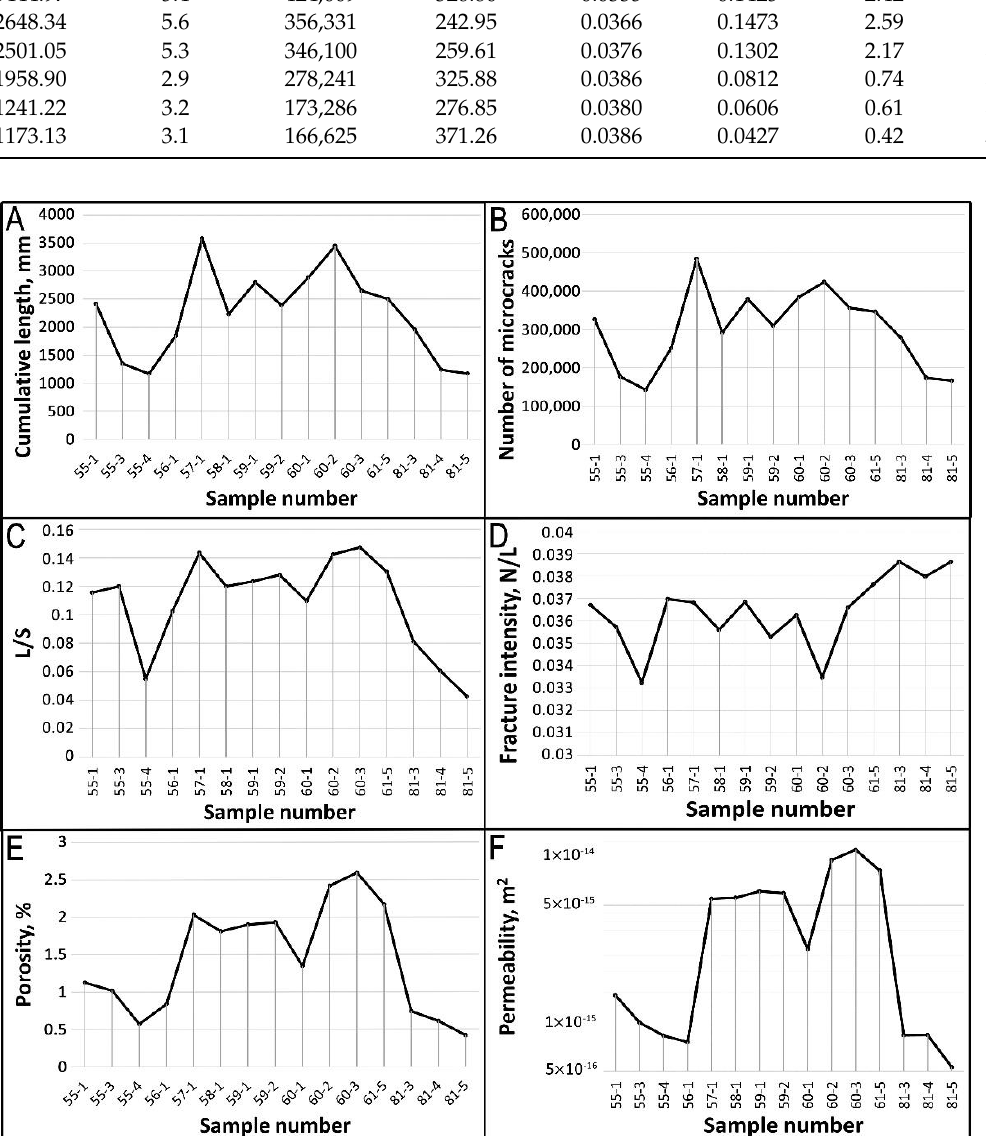
Figure 7. Graphs of the distribution of cumulative length ( A ), number of microfractures ( B ), L/S ( C ), Fracture intensity ( D ), porosity ( E ) and permeability ( F ) of microfractures in oriented thin sections.